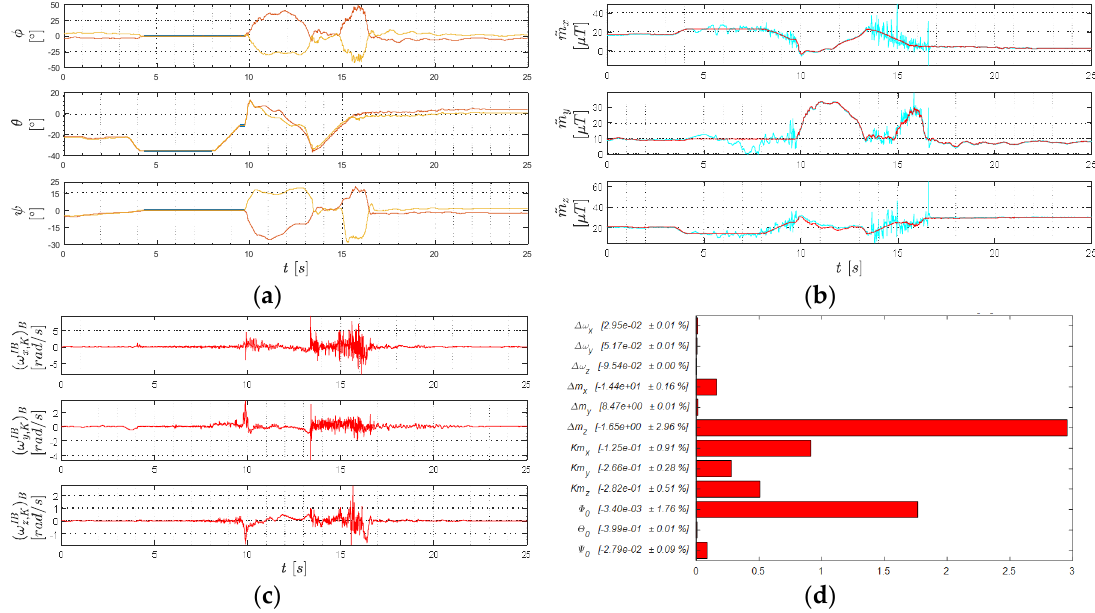
Figure 2. Result for real measurement data: ( a ) Estimated Euler angles of the left ski (red), the right ski (yellow) and the pseudo attitude measurements (blue); ( b ) Estimated output ( (cid:2195) (cid:3549) ) (cid:3003) (red) and the magnetometer measurements (blue) of the left ski; ( c ) The gyroscope measurements of the left ski corrected estimated bias; ( d ) The estimation of relative standard deviation for the left